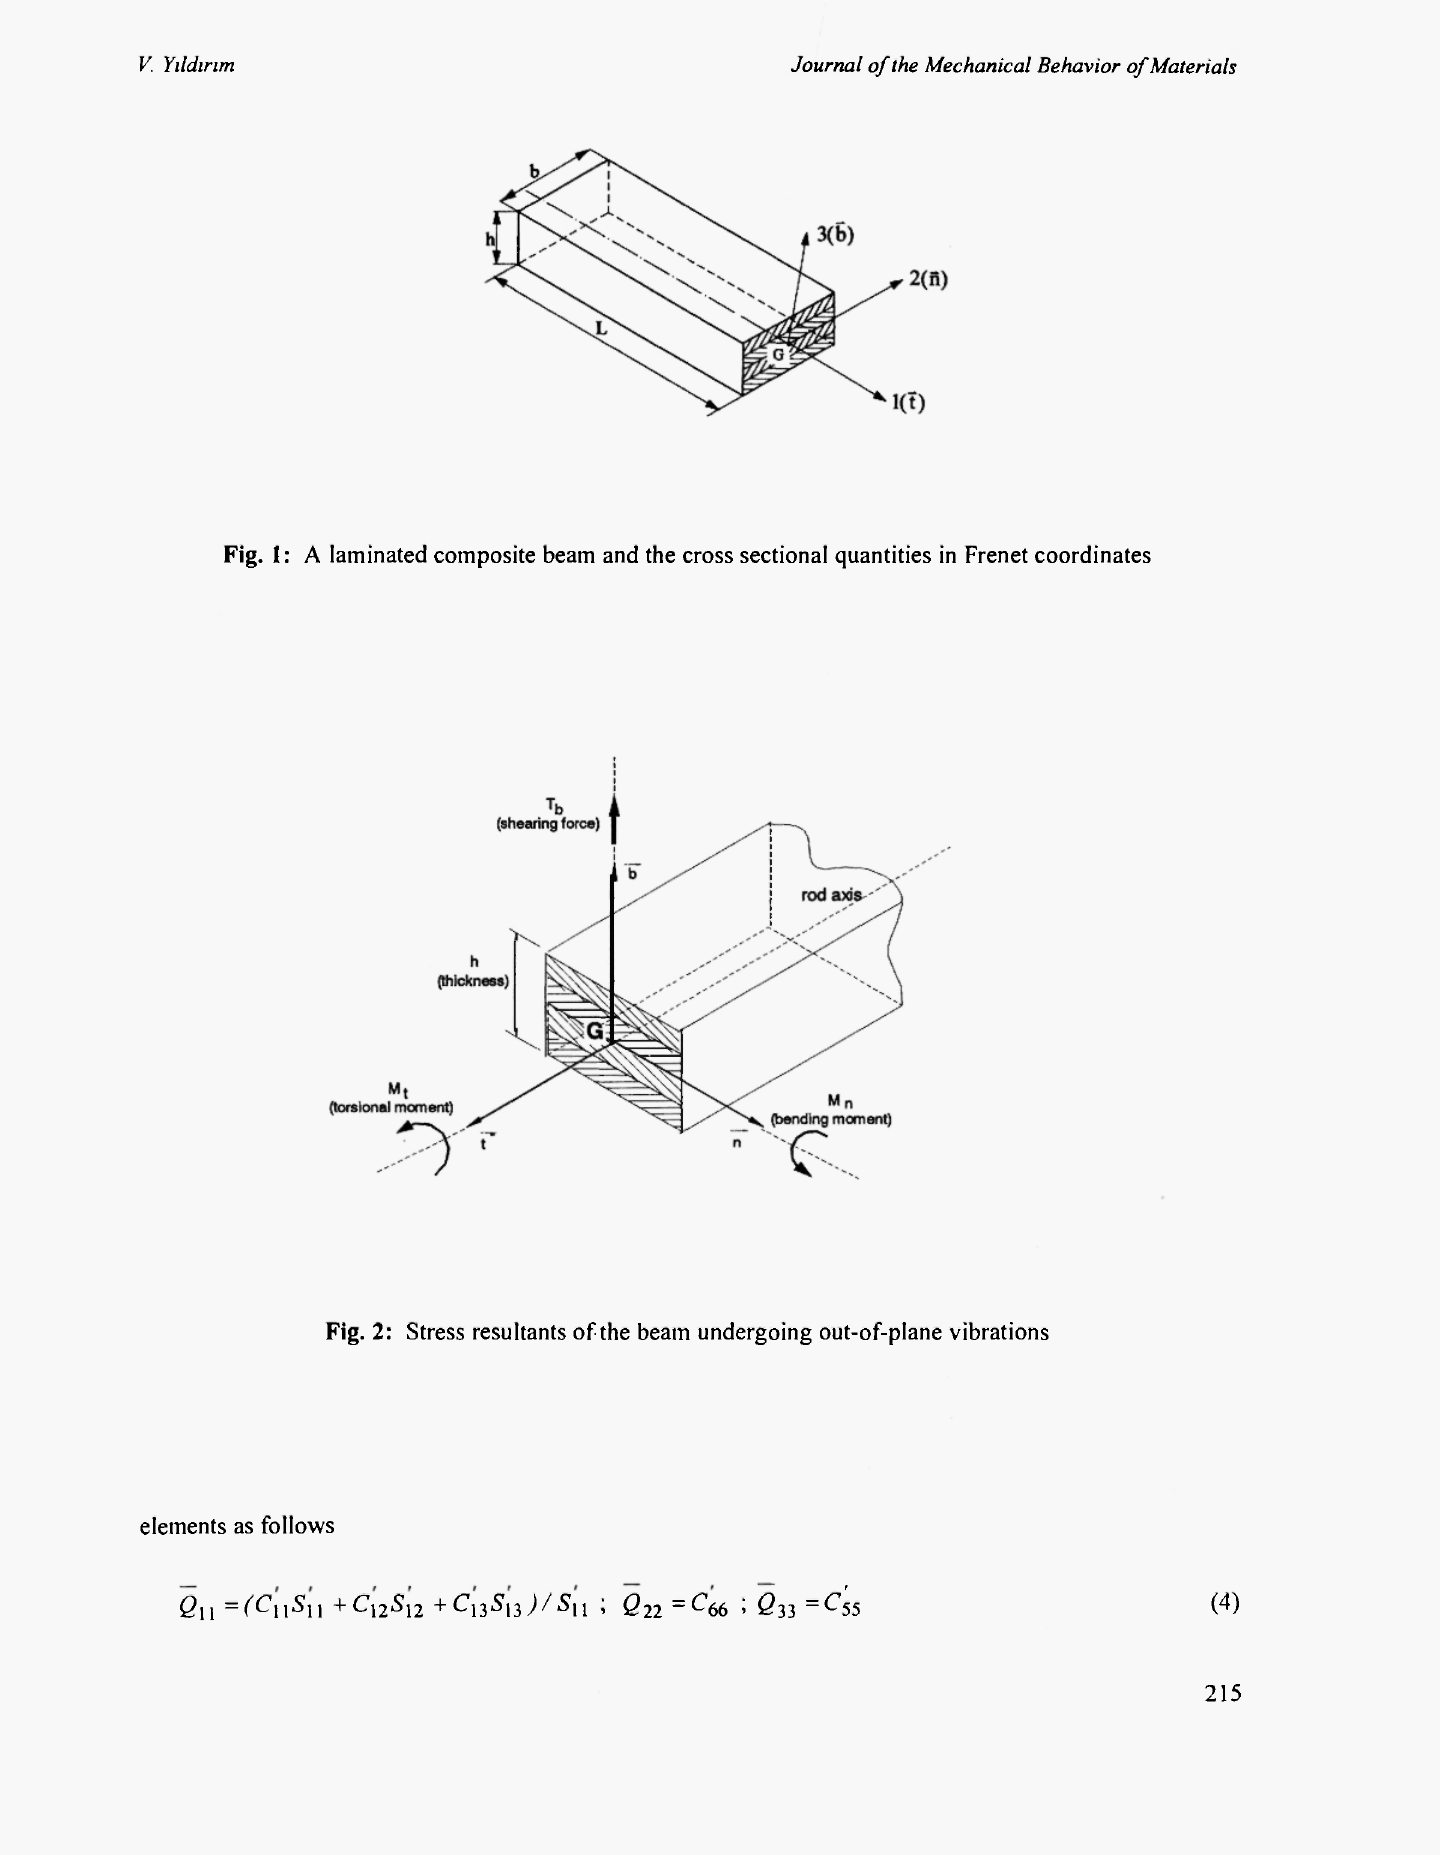
Fig. 2: Stress resultants of the beam undergoing out-of-plane